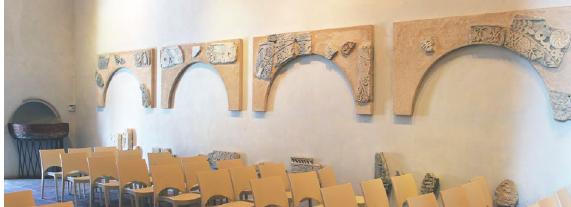
Figure 2. Fragments of sculpted arcades of the original